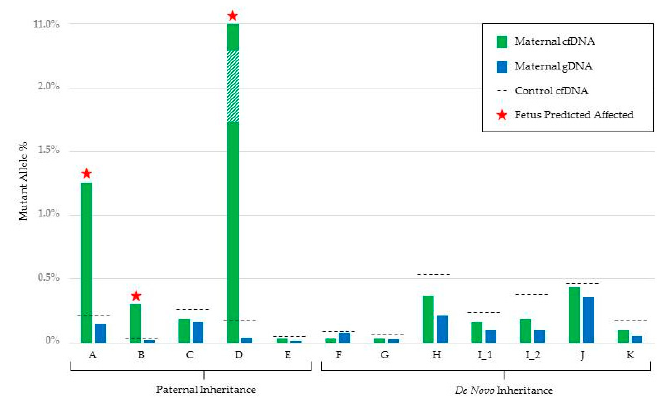
Figure 1. Graphical representation of the mutant allele % detected in both maternal cfDNA (green) and maternal gDNA (blue) for each family tested by amplicon-based MPS. The maternal cfDNA mutant allele % is an average of two duplicate samples. The maximum mutant allele % detected in the five control cfDNA samples is also shown (black dotted line). Tests reported as predicted to be affected are indicated with a star.